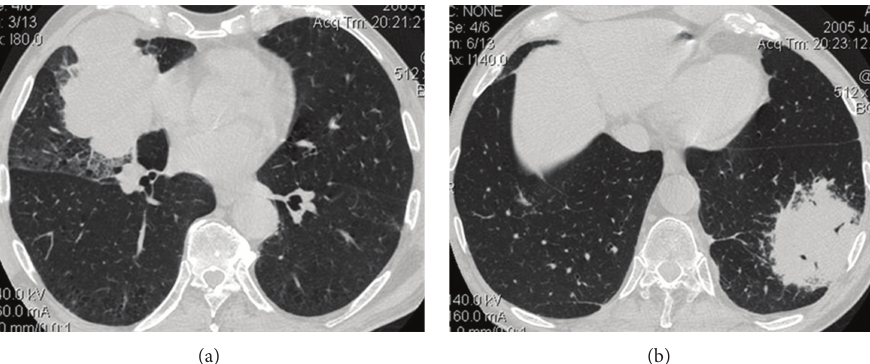
Figure 1: Chest CT on lung window settings shows a lobulated ill-defined mass surrounded by ground-glass opacity in the middle lobe (a) and an ill-defined masslike opacity with air bronchogram centrally in the left lower lobe (b).